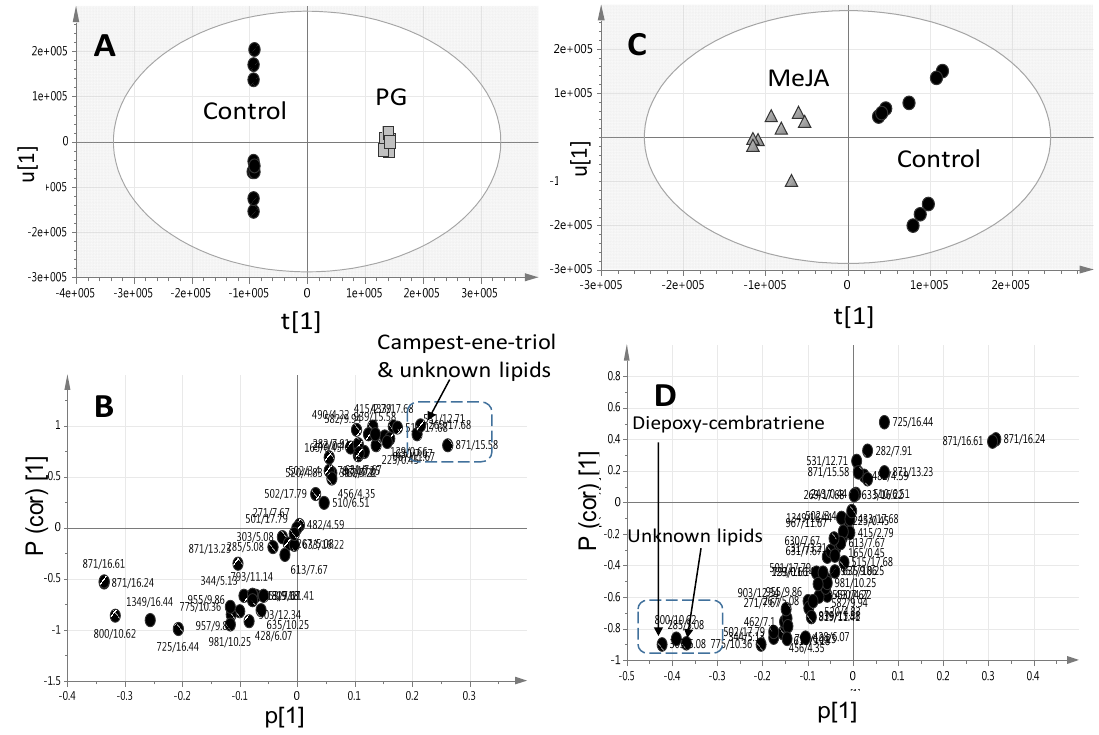
Figure 4. OPLS-DA score plot derived from modelling S. glaucum corals elicited with prostaglandin ( A ) and methyl jasmonate ( C ) at a dose of 20 and 200 μ M each modelled one at a time post elicitation versus control un elicited corals. The S-plots from PG ( B ) and MeJA ( D ) show the covariance p[1] against the correlation p(cor)[1] of the variables of the discriminating component of the OPLS-DA model. Cutoff values of p < 0.05 were used; selected variables are highlighted in the S-plot with m/z and retention time in minutes and identifications are discussed in the text.